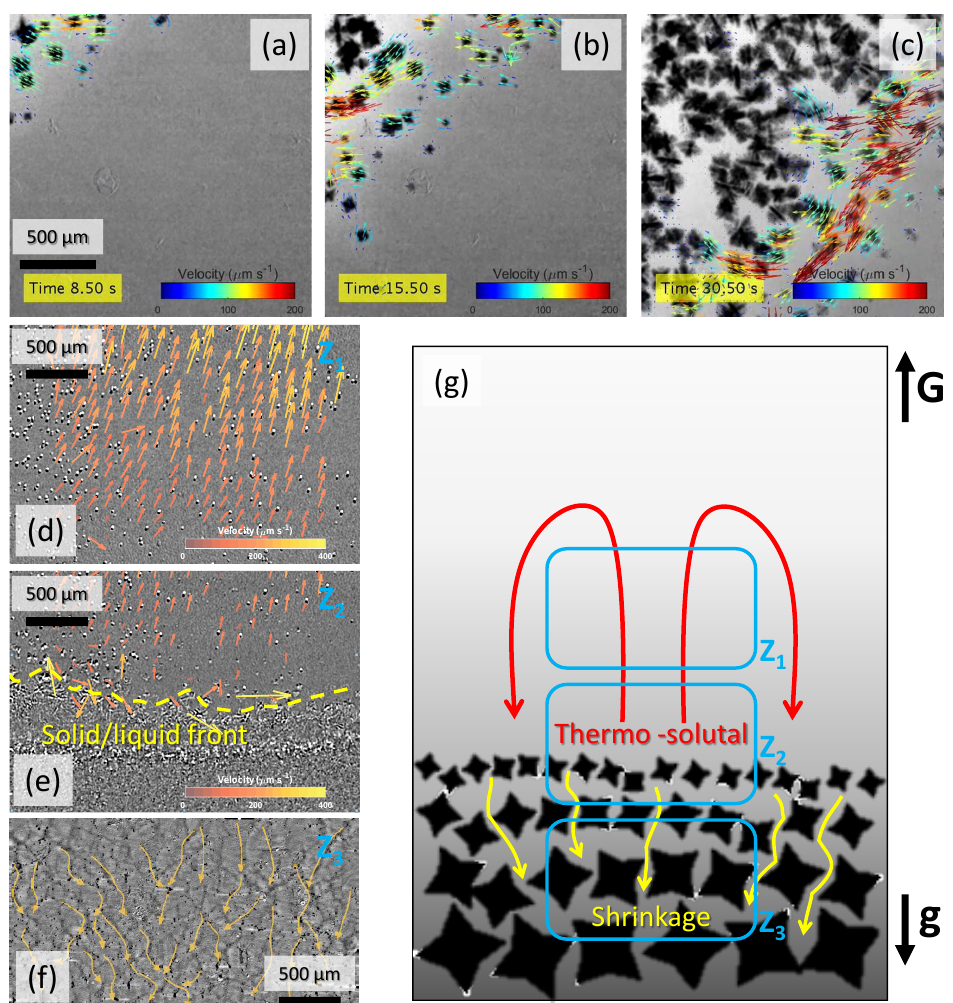
Figure 9. ( a – c ) A radiograph sequence of the solidification of a grain refined Al-15wt.%Cu alloy cooled at 0.3Ks − 1 , showing the movement of equiaxed grains due to shrinkage induced flow. ( d – f ) Radiographs showing the movement of immiscible Pb droplets in an Al-1wt.%Pb alloy, within the bulk liquid ( d ), near the solid liquid interface ( e ) and in the mushy zone ( f ). ( g ) schematic representation of the natural convective flow caused by thermo-solutal effects on liquid density (red) and solidification shrinkage induced flow (yellow). Z 1 —convection dominates; Z 2 —shrinkage and convection; and Z 3 —shrinkage